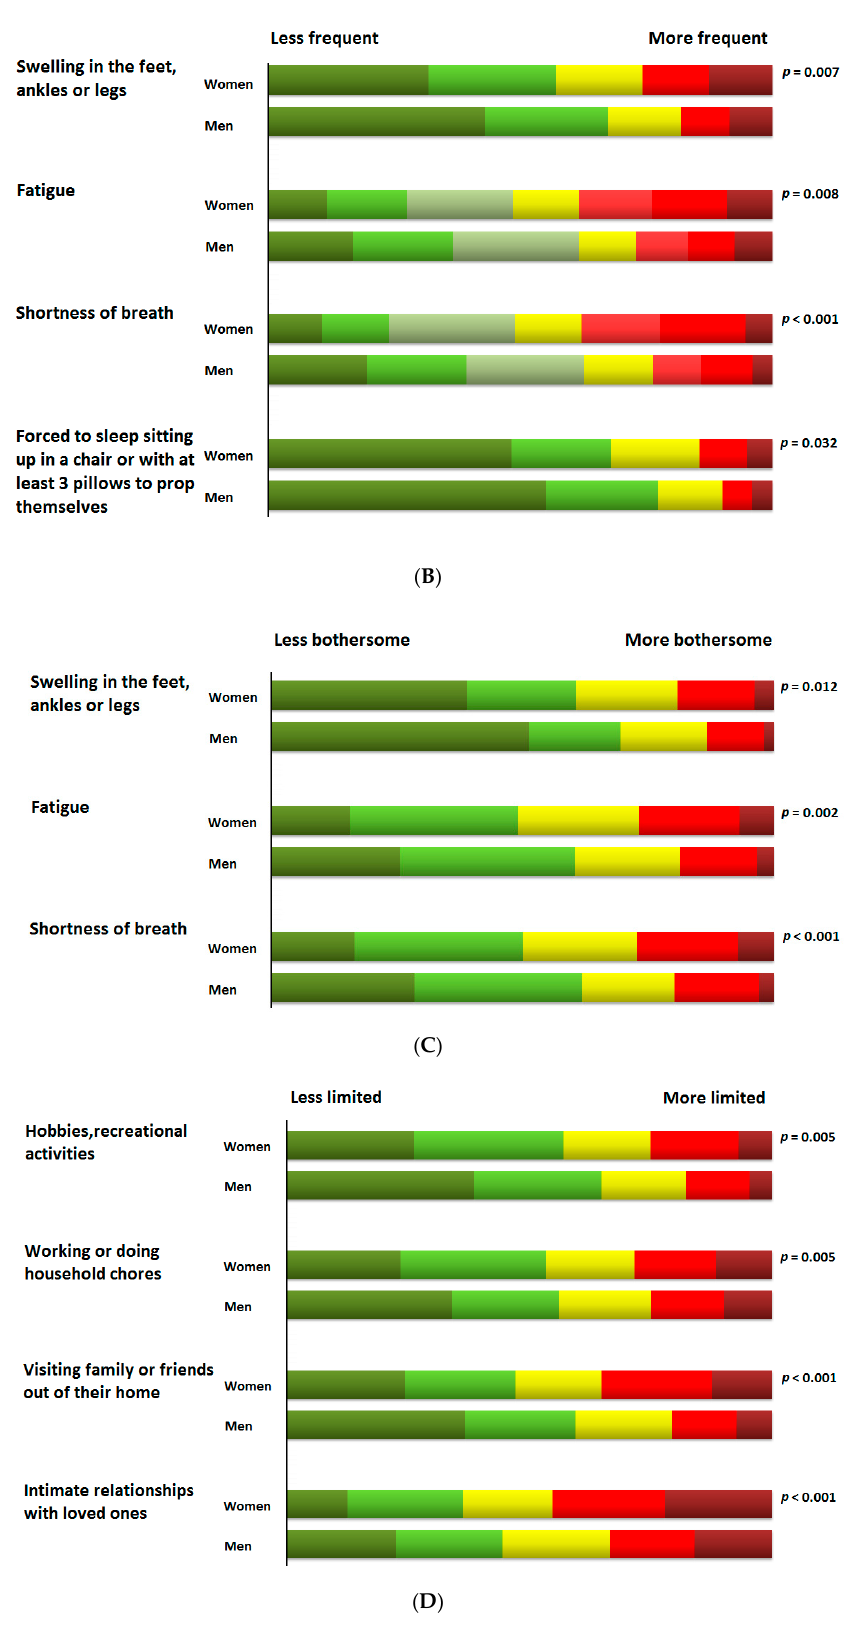
Figure 1. Percentage distribution of scores of the di ff erent KCCQ items in selected domains according to gender. ( A ) Physical limitation; ( B ) Symptom frequency; ( C ) Symptom burden; ( D ) Social